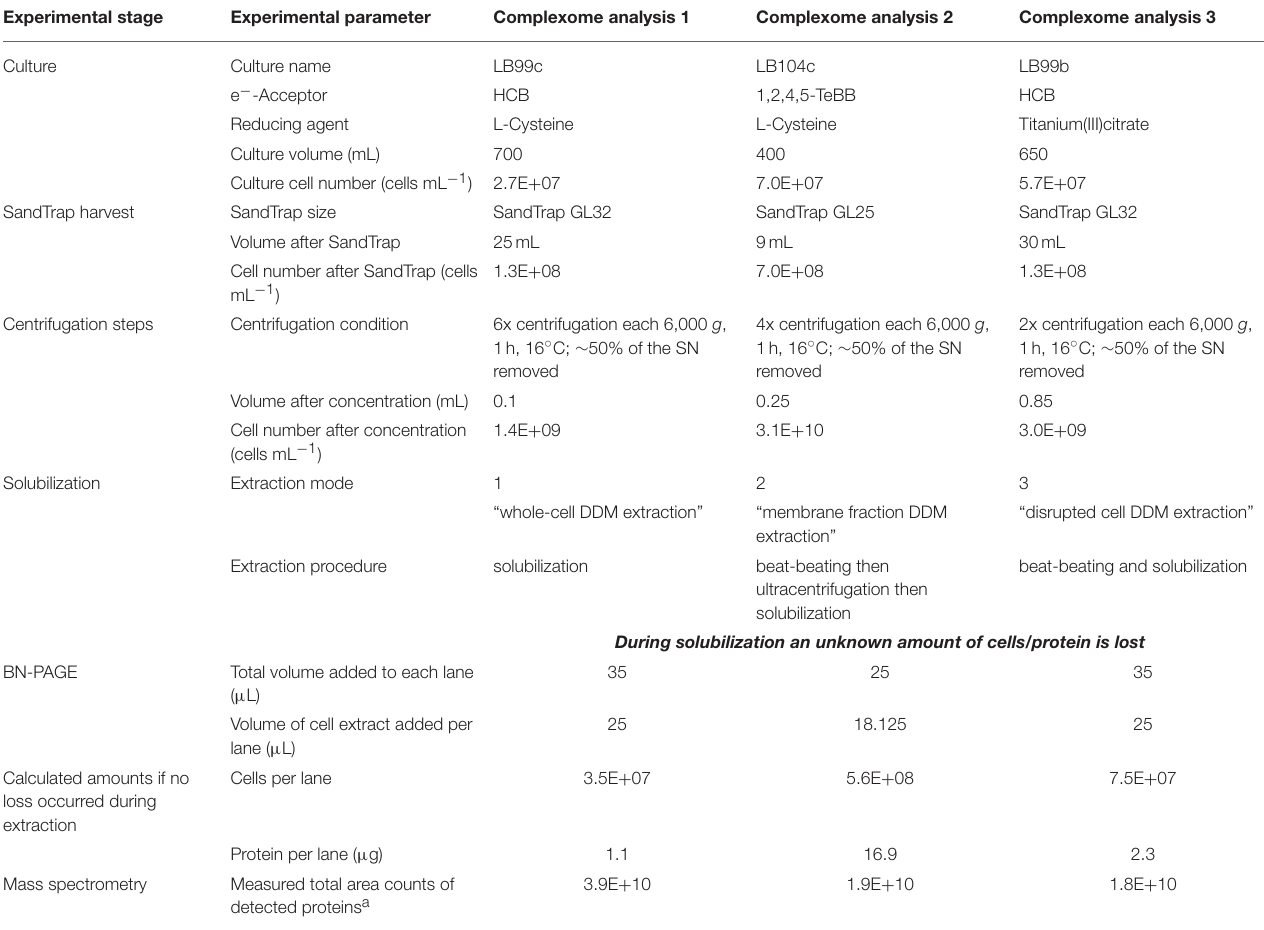
TABLE 1 | Experimental details in complexome analyses with the three different extraction